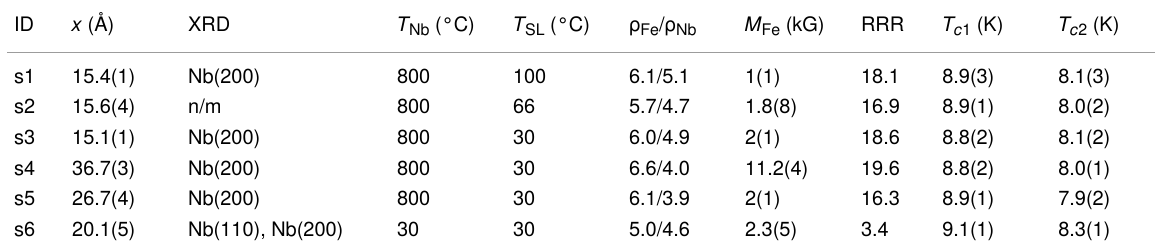
Table 1: Main characteristics of the prepared samples. Here x is the thickness of the Fe layers, the column “XRD” gives the corresponding Miller indices of the peaks observed in the experiment, T Nb and T SL are the temperatures of deposition of the thick Nb layer and the periodic structure, re- spectively, ρ Fe and ρ Nb are, respectively, the nuclear SLD at the center of the nominal Fe and Nb layers, and T c 1 and T c 2 are, respectively, the upper and lower transition